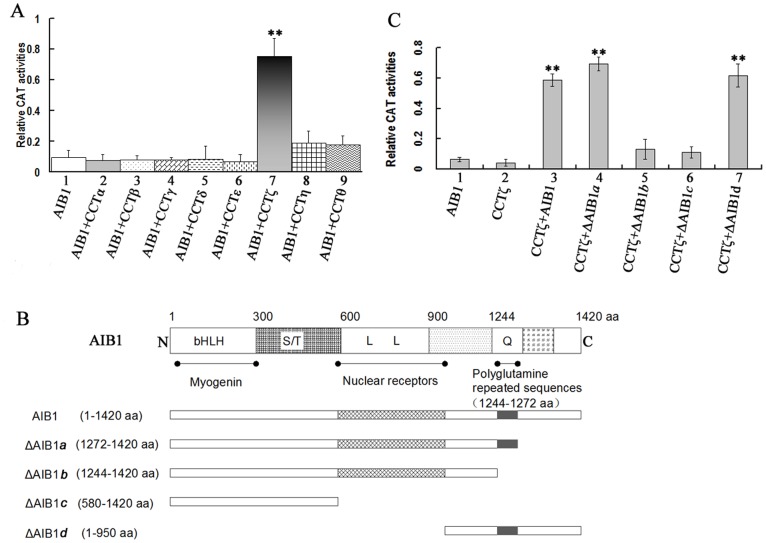
Binding activities of CCTs and AIB1 in MCF-7 cells.(A) The reporter plasmid pG5CAT, expressing CAT, was co-transfected with the pM construct of CCT (α, β, γ, δ, ε, ζ, η or θ) and the pVP16 construct of AIB1 into MCF-7 cells. In the presence of pG5CAT, the control cells were only transfected with the pVP16 construct of AIB1, respectively. CAT activities were measured at a wavelength of 415 nm. Error bars show the standard deviations (n = 6, **P<0.01, compared with other columns). (B) The molecular structure of AIB1, and the constructed fusion proteins in the mammalian two-hybrid protein-protein interaction system were used to compare the binding activities between CCT and AIB1 or truncated forms of AIB1. The numbers at the top indicate the position of the amino acid sequence. The letters within the bar indicate structural domains, and the lines under the bar indicate functional domains. bHLH, basic helix-loop-helix domain; L, LXXLL α-helix motif; S/T, serine/threonine-rich region; Q, glutamine-rich domain. (C) Binding activities of CCTζ and AIB1 or four truncated forms of ΔAIB1 (a to d) in MCF-7 cells. The constructed fusion proteins in the mammalian two-hybrid protein-protein interaction system were used to compare the binding activities between the full-length CCTζ and wild-type AIB1, or truncated forms of AIB1. The reporter plasmid pG5CAT was co-transfected with the pM construct of CCTζ and the pVP16 construct of AIB1 or the four types of truncated AIB1 into MCF-7 cells. In the presence of pG5CAT, two control cell lines were only transfected with the pVP16 construct of AIB1 or the pM construct of CCTζ, respectively. Error bars show standard deviations (n = 3) of three independent experiments in duplicate (**P<0.01, column 3, 4 or 7 vs. column 5 or 6).